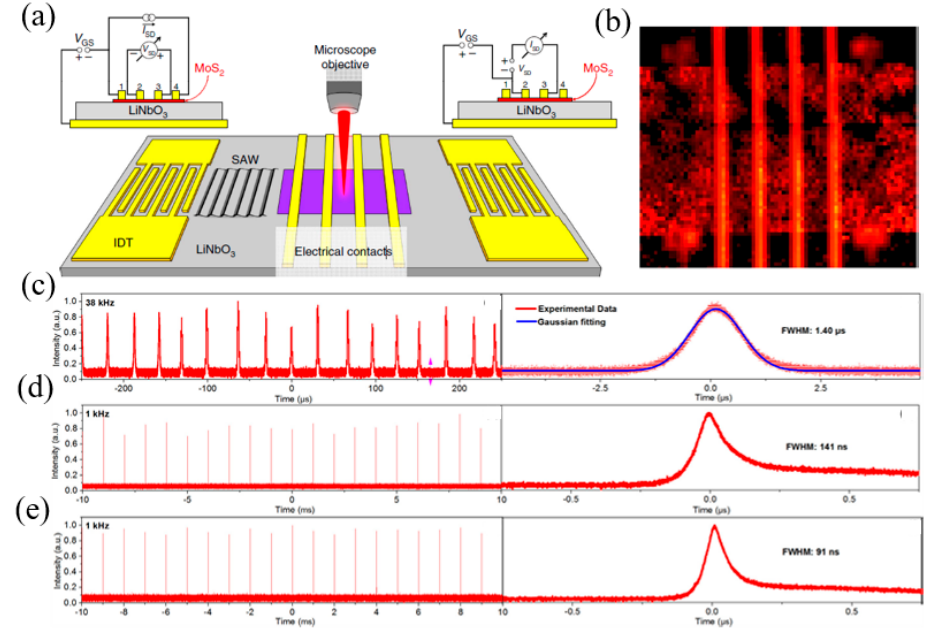
Figure 17. ( a ) Schematic diagram of device based on MoS 2 /LiNbO 3 combination. ( b ) PL map of the active FET region [292]. Copyright 2015 Nature Publishing Group. ( c ) Pulse trains of lasers and single pulses of WS 2 Q-switched. ( d ) AOM&WS 2 Q-switched at 1 kHz. ( e ) AOM&WS 2 based Q-switching at 1 kHz [293].